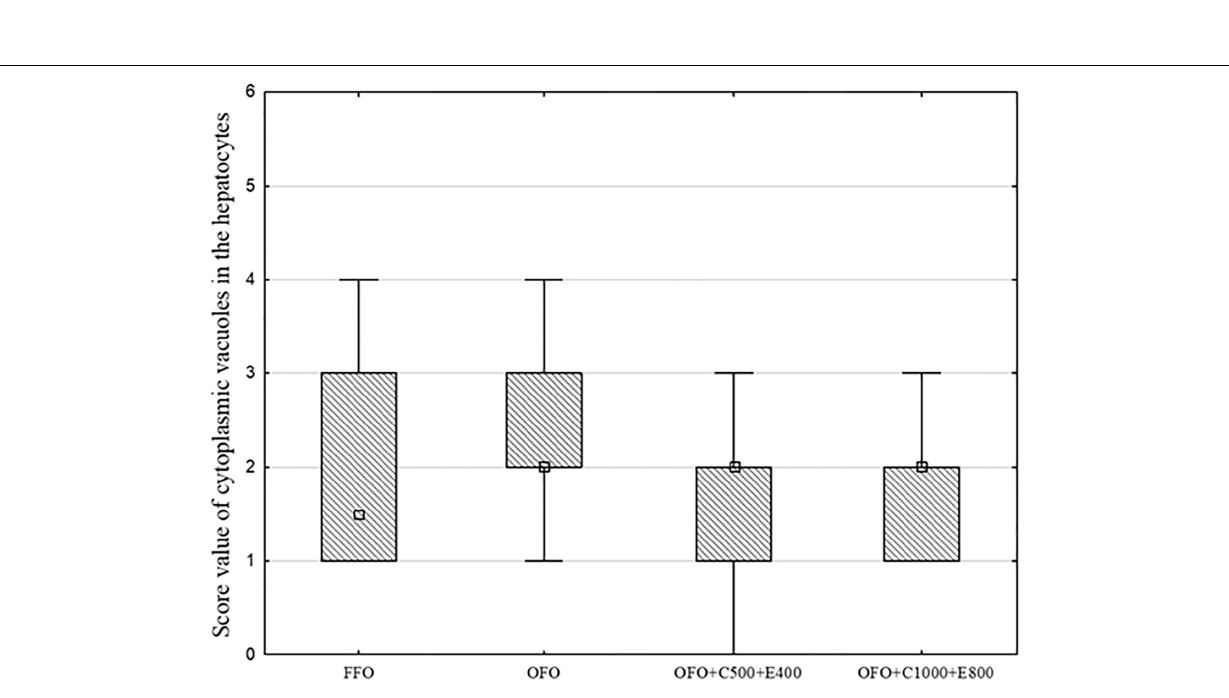
Frontiers in Marine Science |